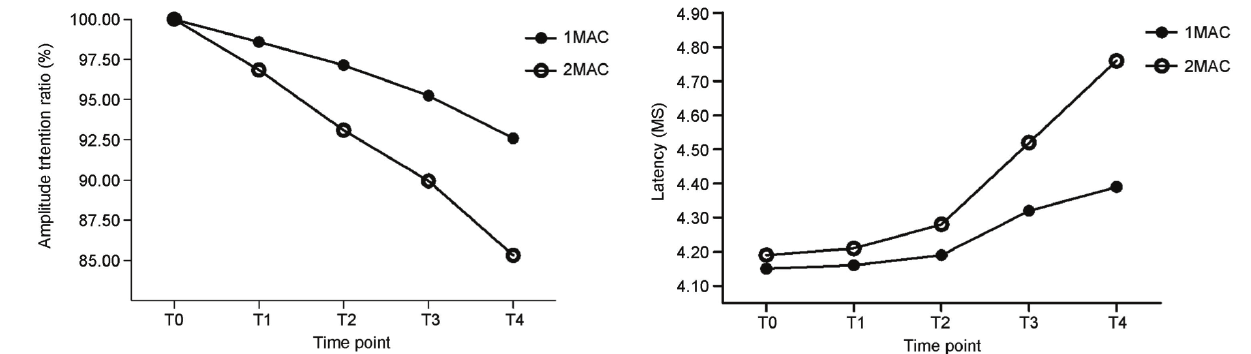
Figure 1: The charge trends of amplitude retention ratio. Figure 2: The charge trends of